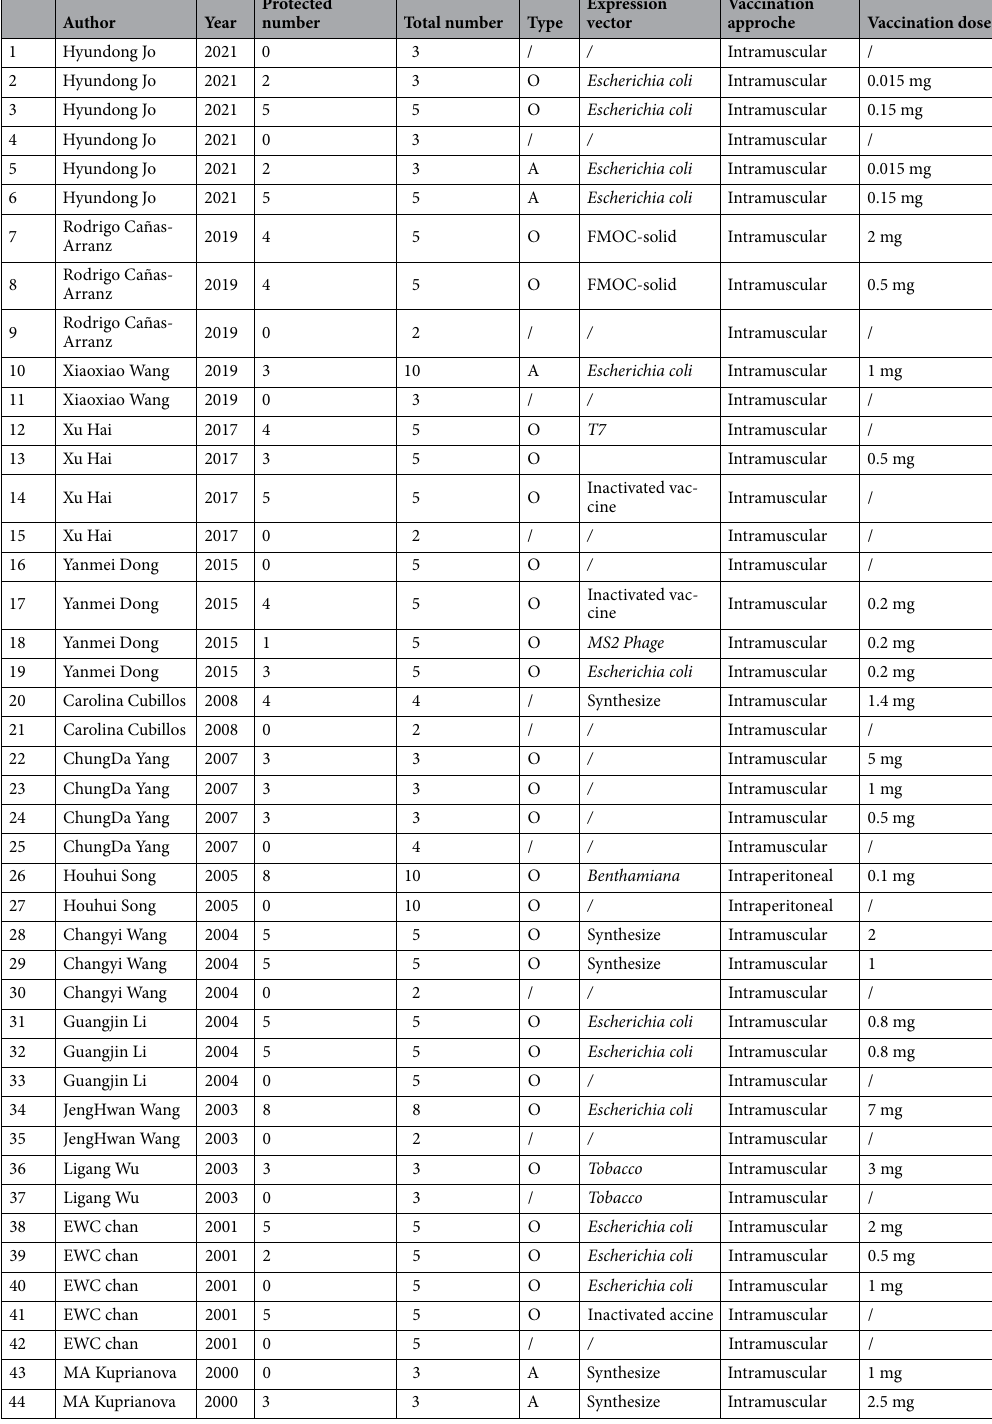
Table 1. Characteristics and summary findings of the selected studies 2,8–11,13–20